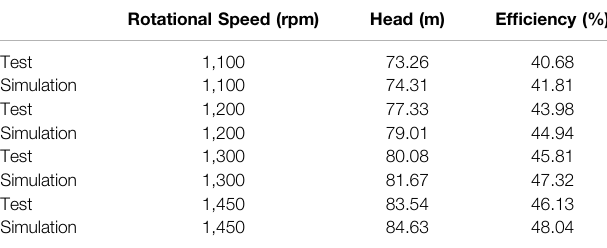
TABLE 6 | Test and simulation results.